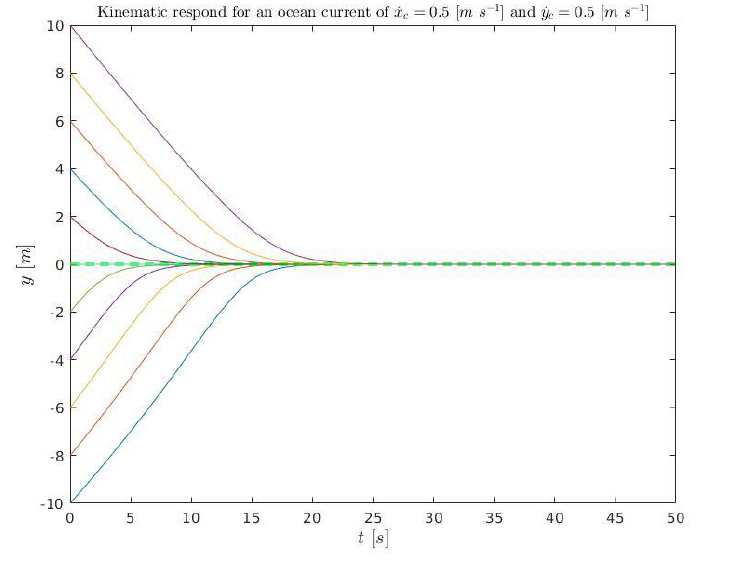
Figure 19. Kinematic simulation for the conditions (37) relative to time. The colored lines represent the different simulations and the green discontinuous line the acceptance